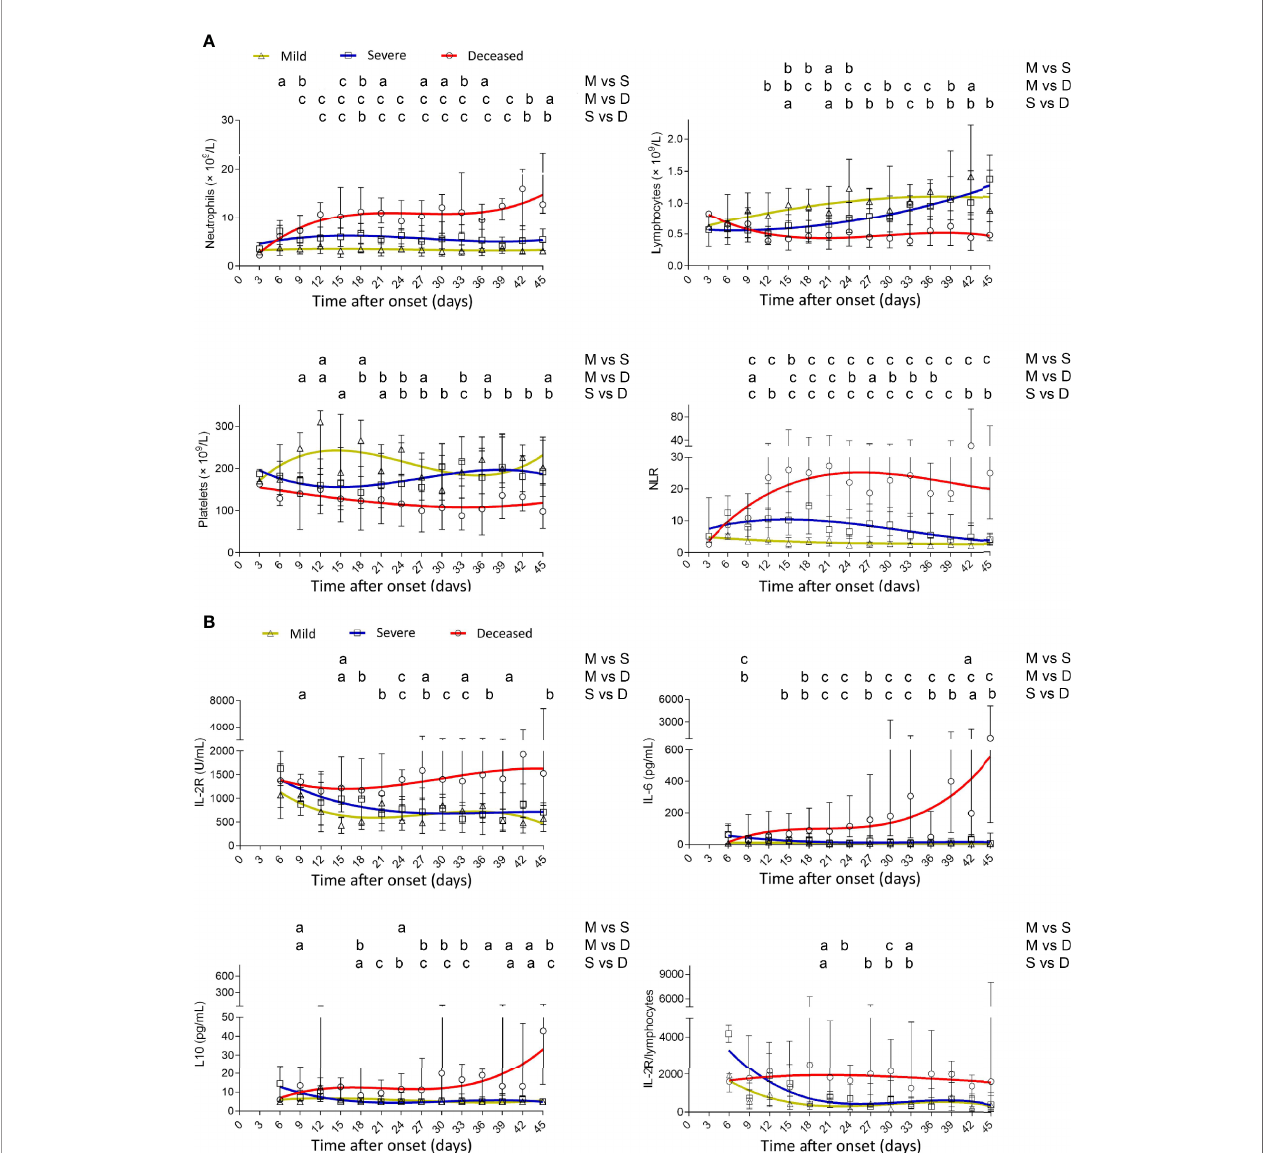
FIGURE 1 | Dynamic analysis of routine blood test and cytokines in patients with different outcomes. (A) The absolute numbers of neutrophils, lymphocytes, platelets, and NLR and (B) the values of IL-2R, IL-6, IL-10, and IL-2R/lymphocytes in the peripheral blood of mild (yellow line), severe (blue line), and deceased (red line) COVID-19 patients were analyzed at different time points (every 3 days from day 3 to day 45 after onset of illness). Data in each time point are expressed as median with interquartile range. The smoothing cubic splines were fi tted to the values of different parameters to summarize the overall trend. NLR, neutrophil-to- lymphocyte ratio; IL-2R, IL-2 receptor. a p < 0.05; b p < 0.01; c p < 0.001. M, mild; S, severe; D,